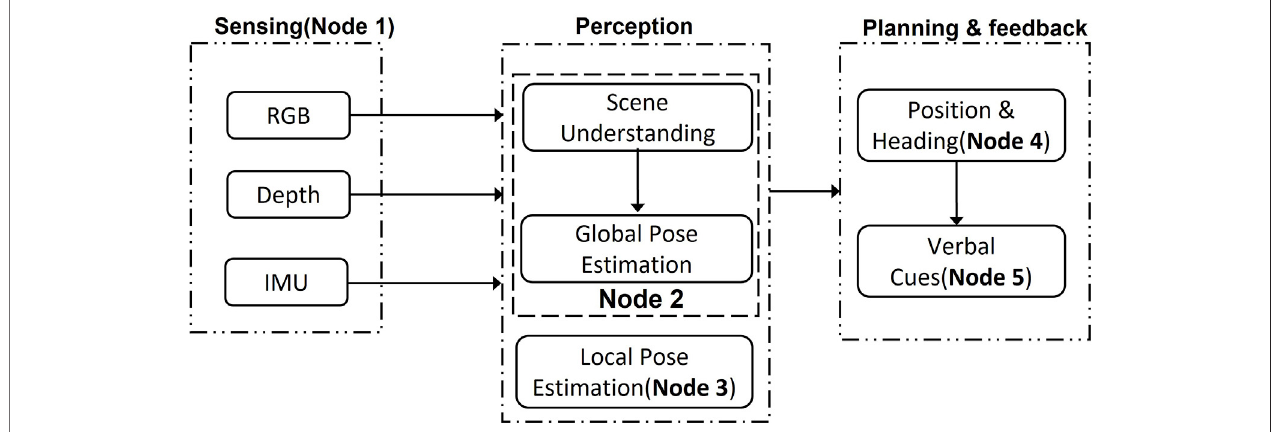
FIGURE 1 | The navigation system contains several ROS nodes. Five different nodes are running on a Jetson machine simultaneously, and each node communicates through the message system provided by ROS. Sensing is one node. Perception has two nodes, and Planning and Feedback has two